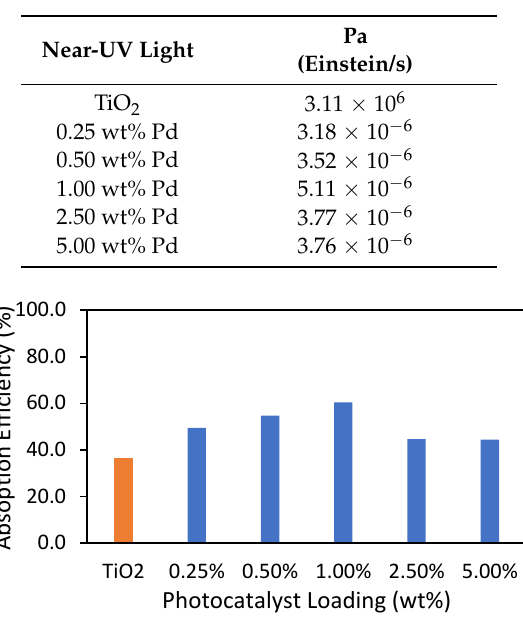
Figure 5. Absorption efficiency on TiO 2 photocatalysts at different metal loadings under near-UV light.